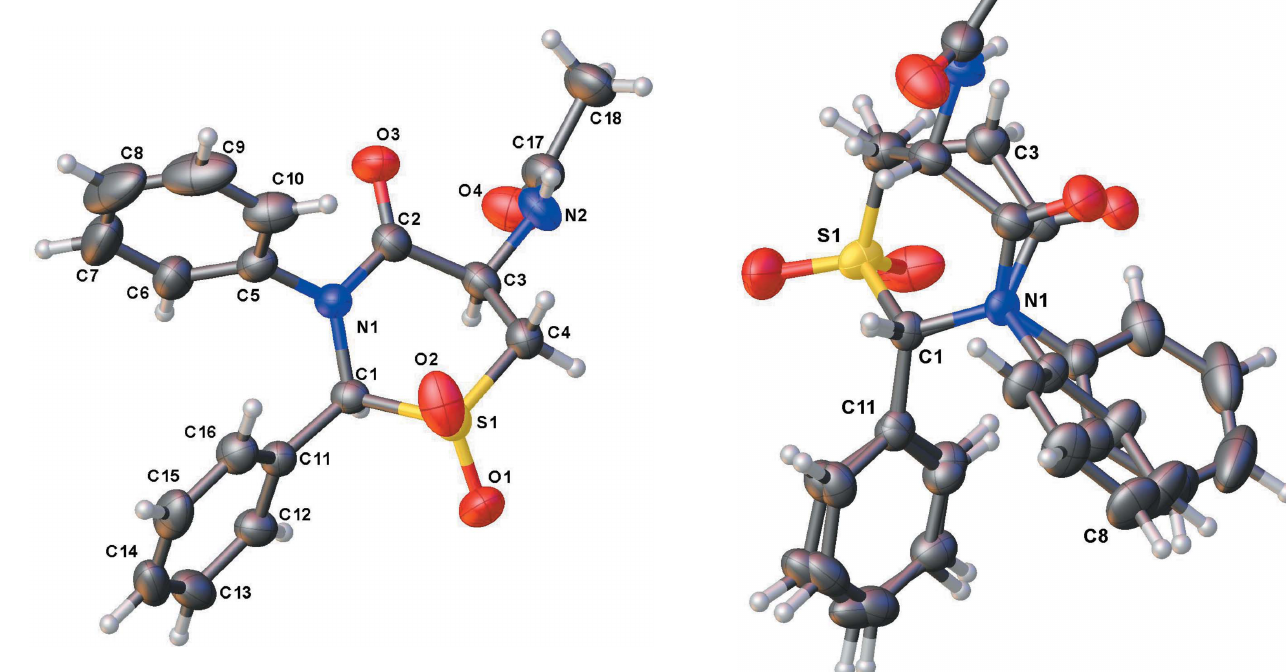
Figure 3 Overlay plot of 1 and 2 where the three atoms S1, N1, and C11 are matched. Atoms C3 and C8 of compound 1 are labeled.